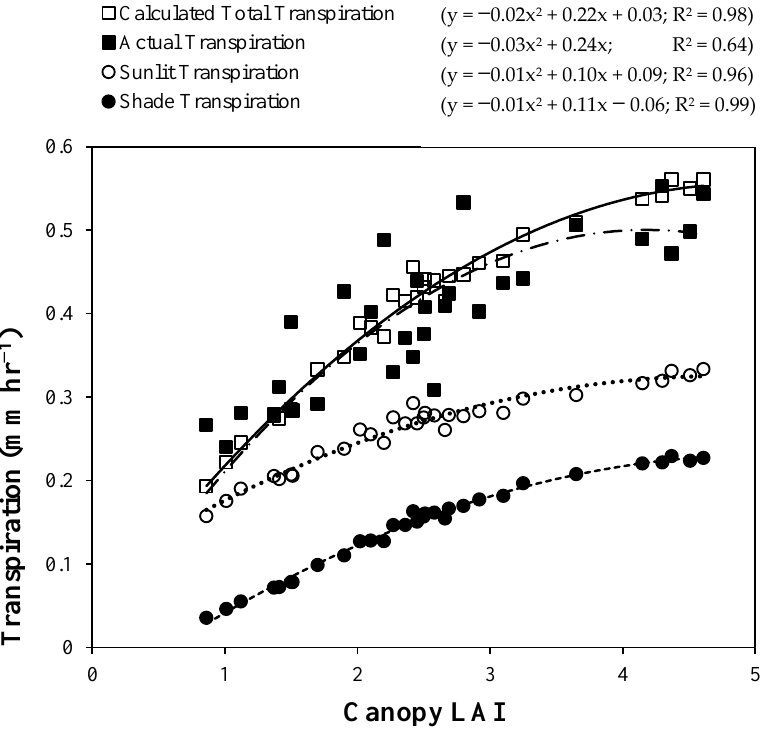
Figure 6. Measured ( ■ , dotted line), predicted total transpiration (□, solid line), sunlit transpiration ( ○ , long dashed line) and shaded transpiration (●, short dashed line) for the canopy layers and overall canopy with LAI. All trend curves are significant polynomial fits ( p < 0.001).